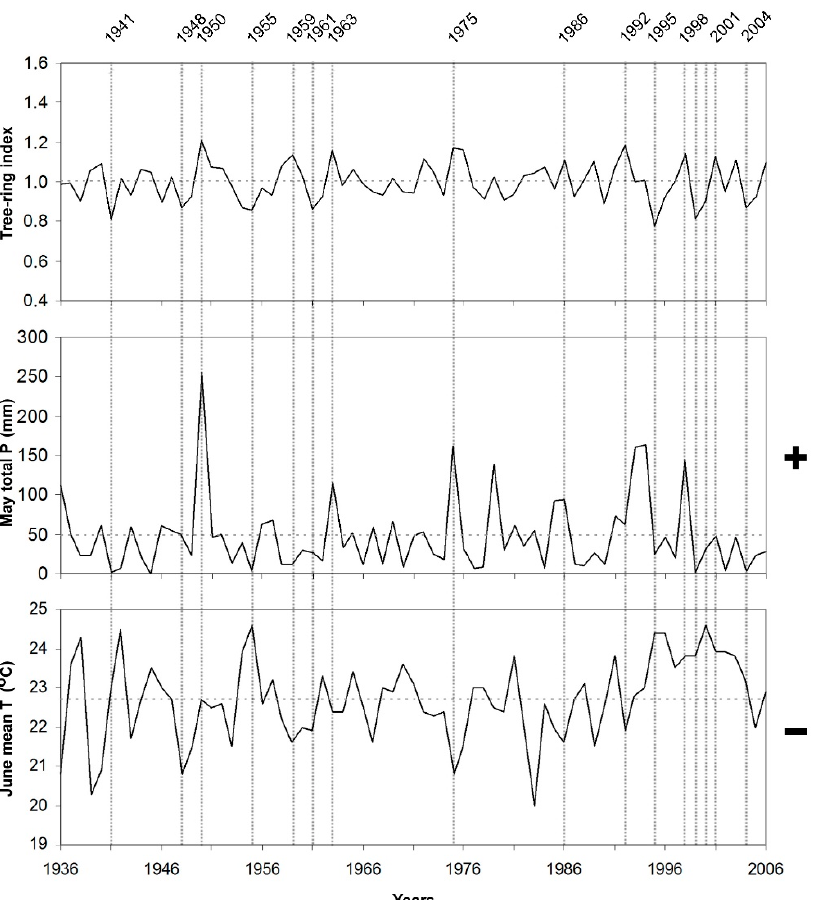
Figure 7. Residual chronology of upper limit of black pine on the north slope (CIU site), and limiting climate factors, which are May total precipitation and June mean temperature in the period of 1936–2006. Vertical dashed lines represent pointer years, which have very narrow and large ring formation years. Horizontal dashed lines represent the average value. “ + ” and “ − ” represent the positive and the negative correlation between climate factors and tree-ring width, respectively.